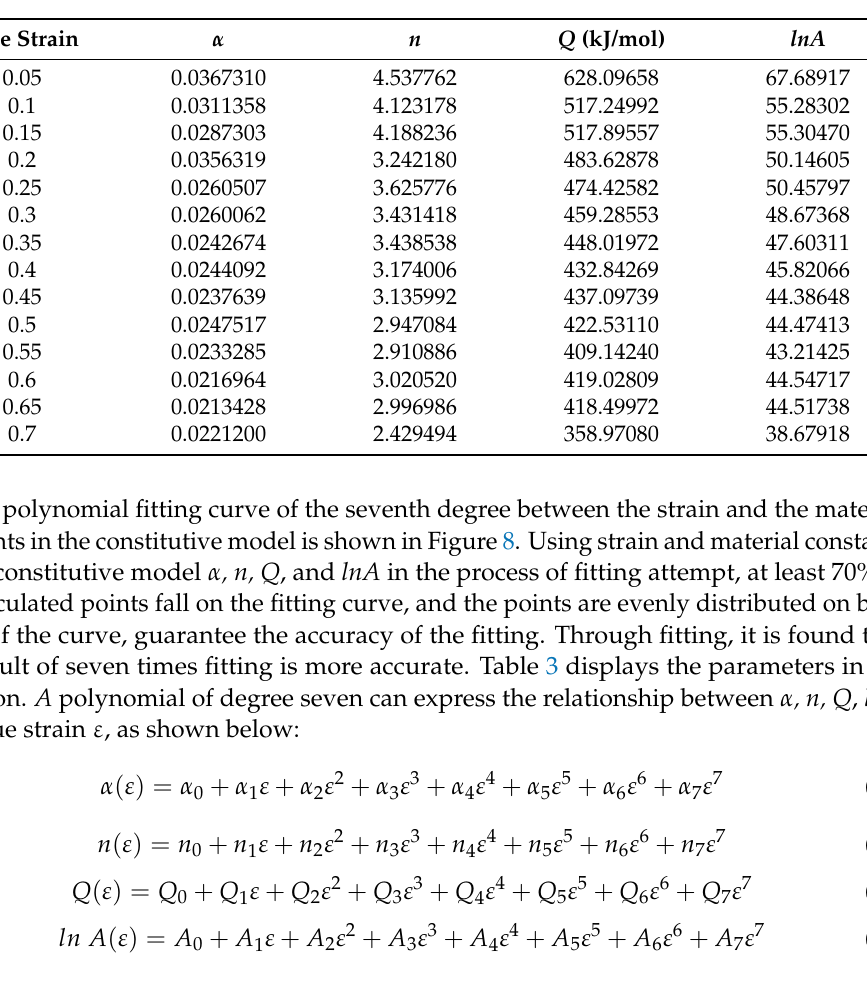
Figure 7. Relationship between ln Z and ln [ sin h ( ασ )] . Table 2. Calculation results of α , n, Q , and lnA , when the true strain is in the range of 0.05–0.70. True